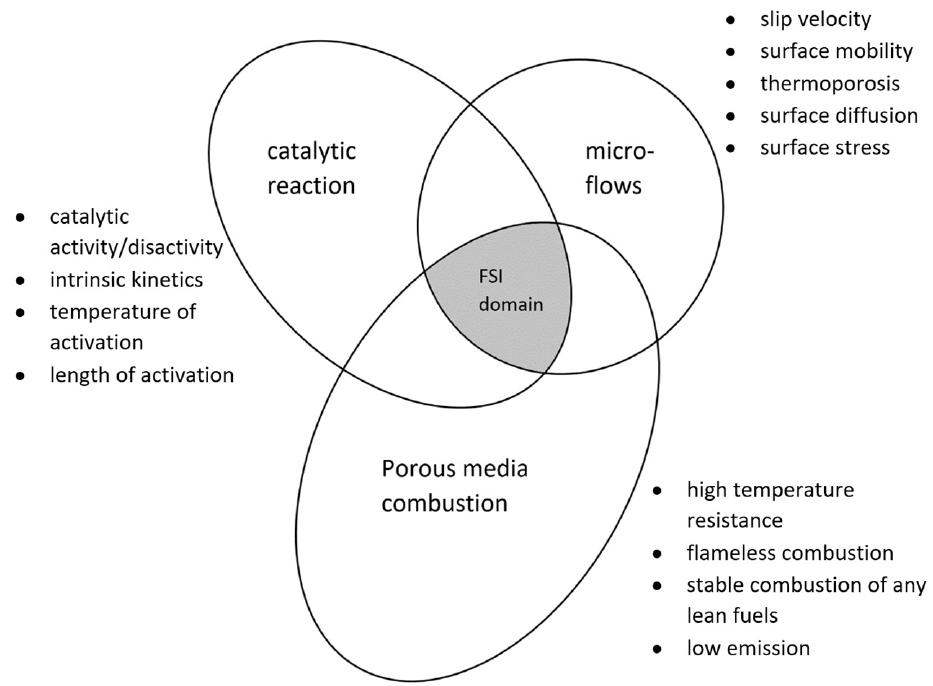
Figure 1. Scheme of FSI domains of interest.